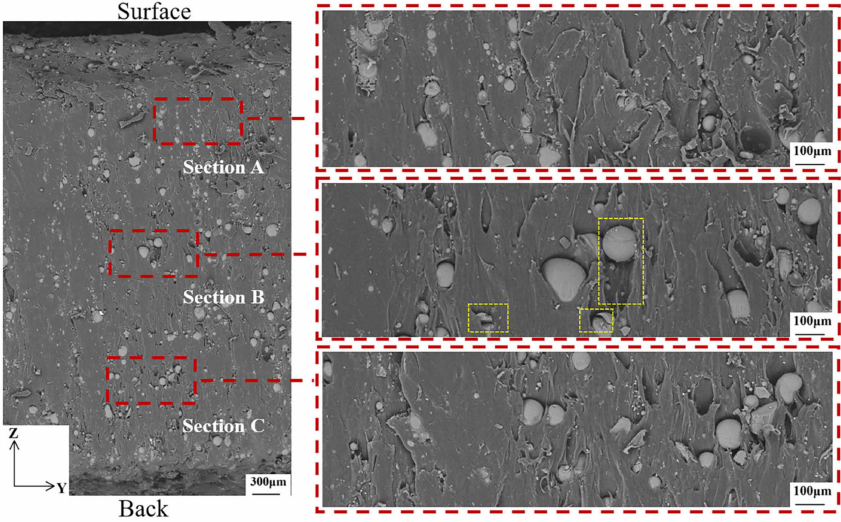
Figure 11. Microscopic morphology of the motor after ablation in the ZOY